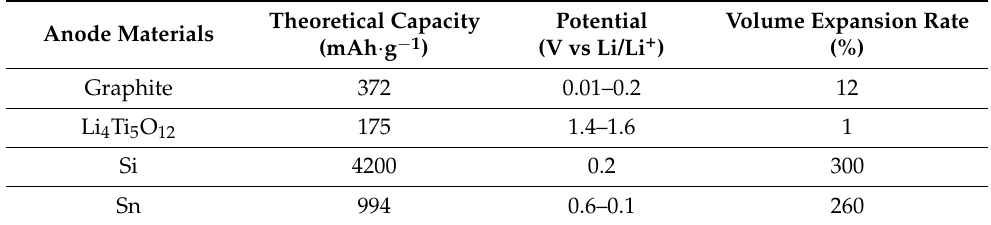
Table 2. Anode materials of LIBs and their basic